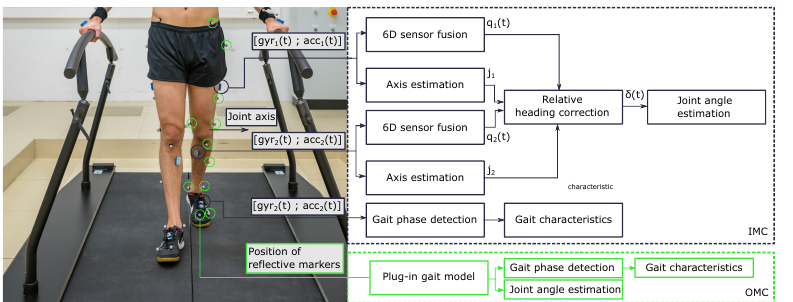
Figure 2. Overview of the data-processing steps in validation of estimated gait kinematics and temporal parameters using IMUs.